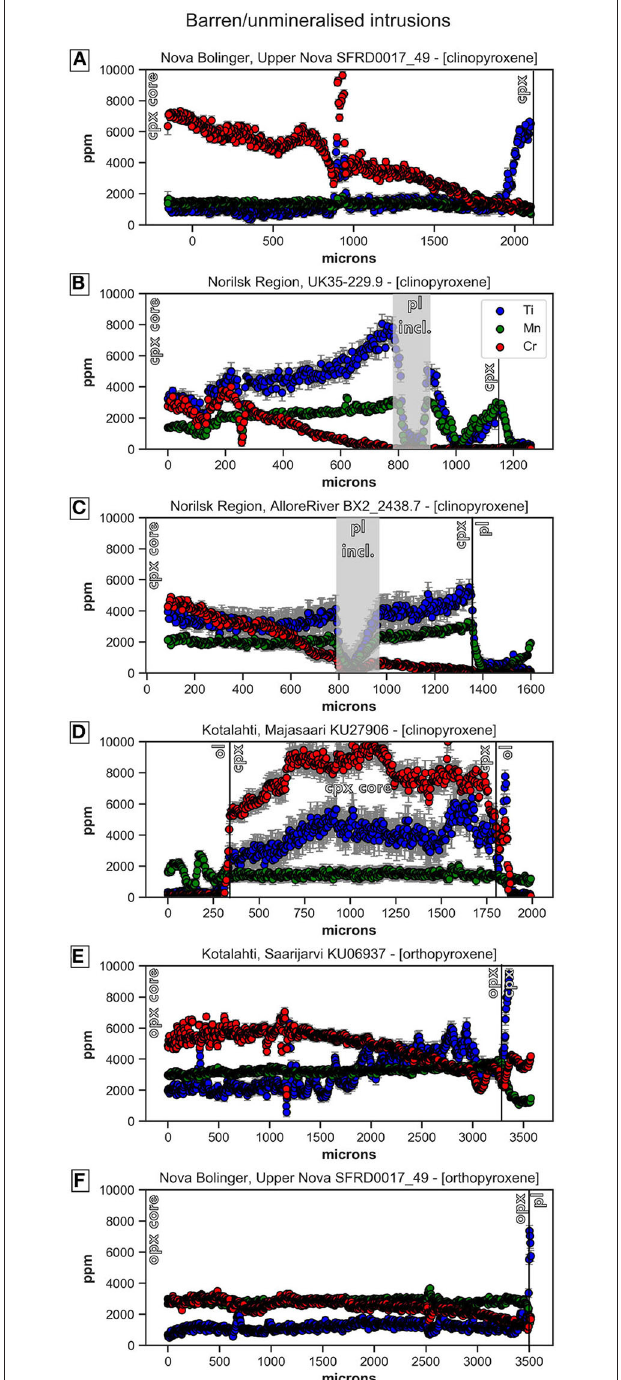
FIGURE 8 | Traverses across clinopyroxene and orthopyroxene from core to rim in barren and unmineralized intrusions. (A) Clinopyroxene from Upper Nova intrusion ( Figure 7E ), (B) clinopyroxene from Chernogorsk, Norilsk Region ( Figure 7F ), (C) clinopyroxene from the Allore River intrusion, Norilsk Region ( Figure 7G ), (D) a traverse from clinopyroxene edge to edge through core from the Majassaari intrusion of the Kotalahti Ni Belt ( Figure 7A ), and (E) core to rim traverse through an orthopyroxene of the Saarijarvi intrusions, Kotalahti Ni-belt ( Figure 7C ). (F) An orthopyroxene from Upper Nova intrusion ( Figure 7E